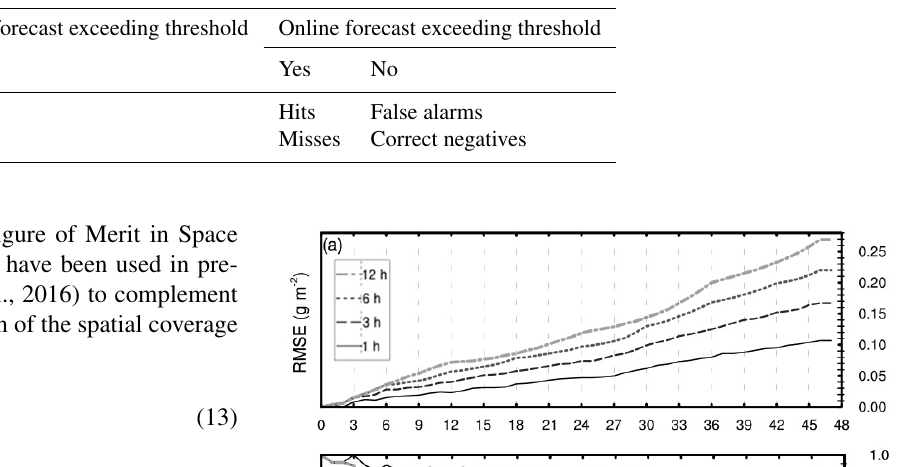
Table 1. Contingency table of binary events for categorical verification scores at each grid point.